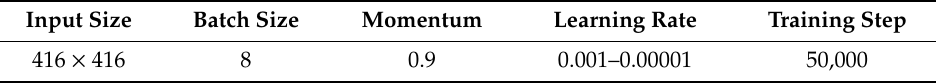
Table 4. The initialization parameters of